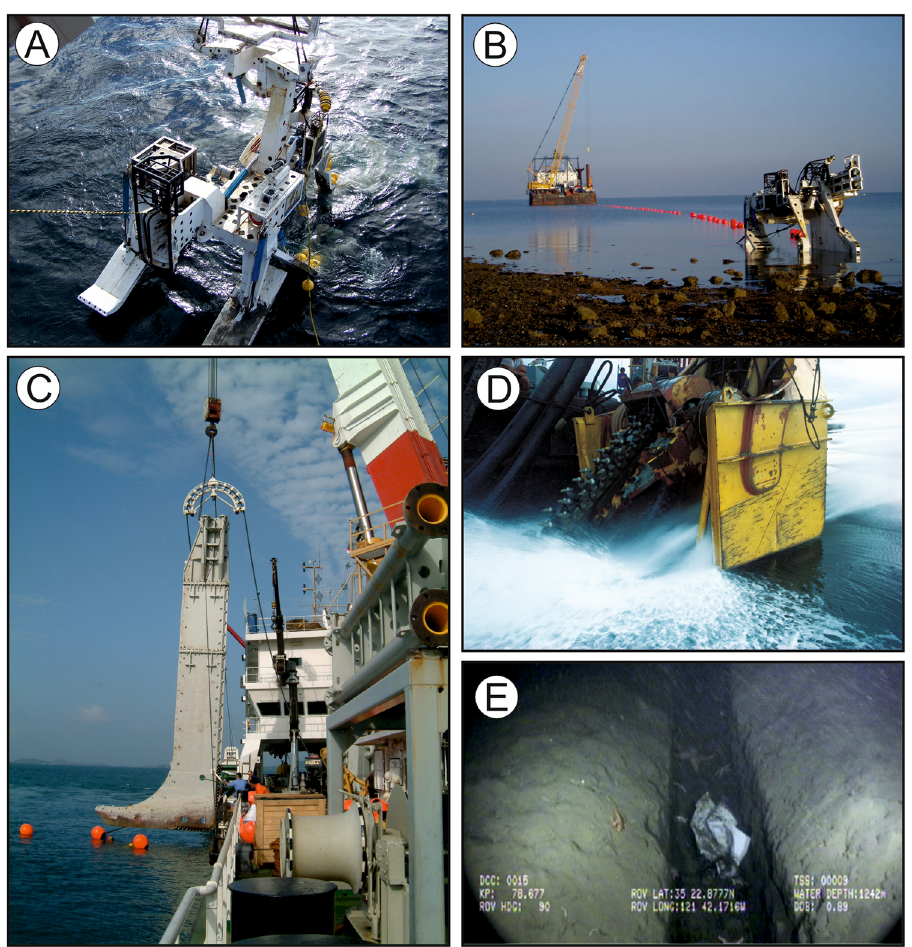
Fig. 2 | Various devices used to excavate trenches for cable burial. Devices include A , B plough, C jet, and D mechanical trencher. A photograph of a steep- sided 0.5 m-wide trench at 1242m water depth is shown in E that was excavated